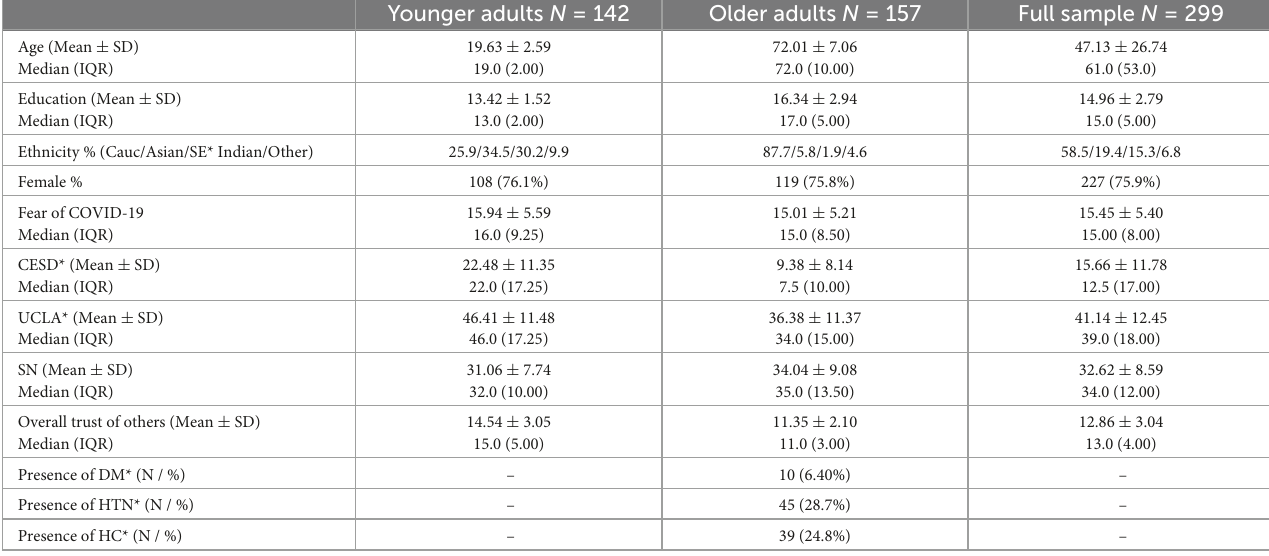
TABLE 1 Characteristics and demographics of the young and older adults, and full sample.